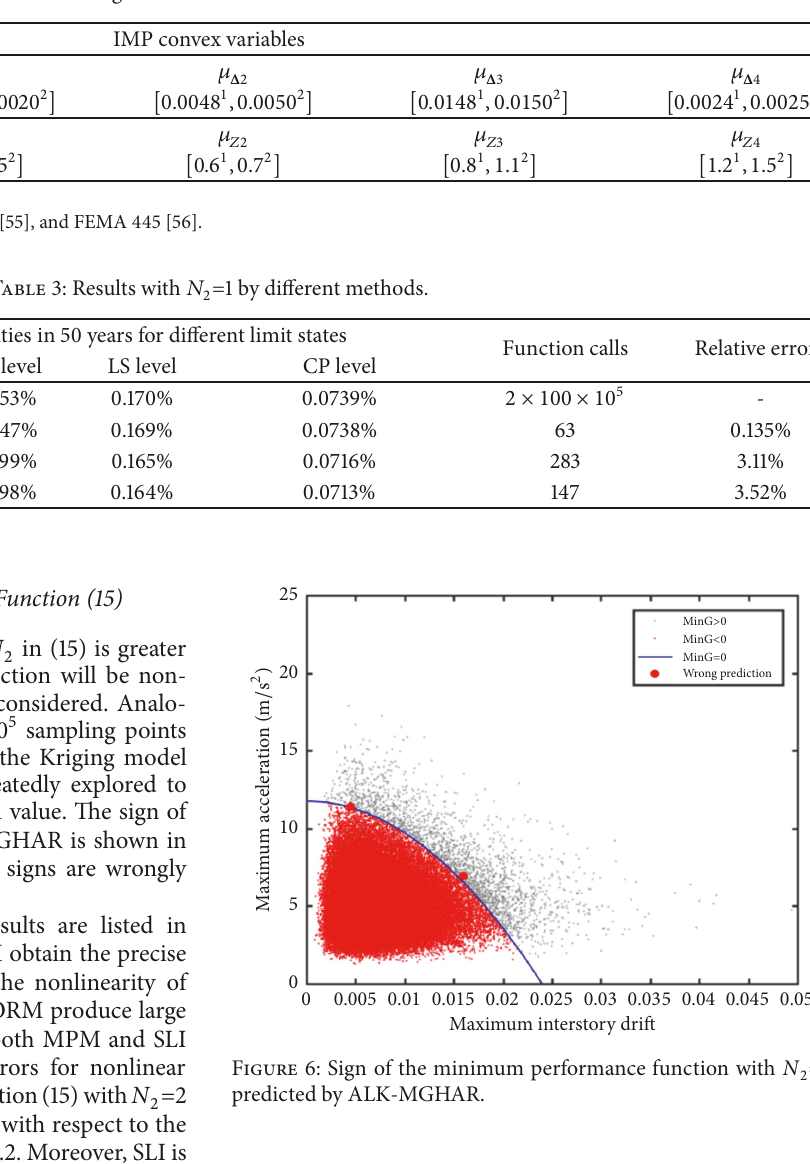
Table 2: The marginal intervals of IMP convex variables.